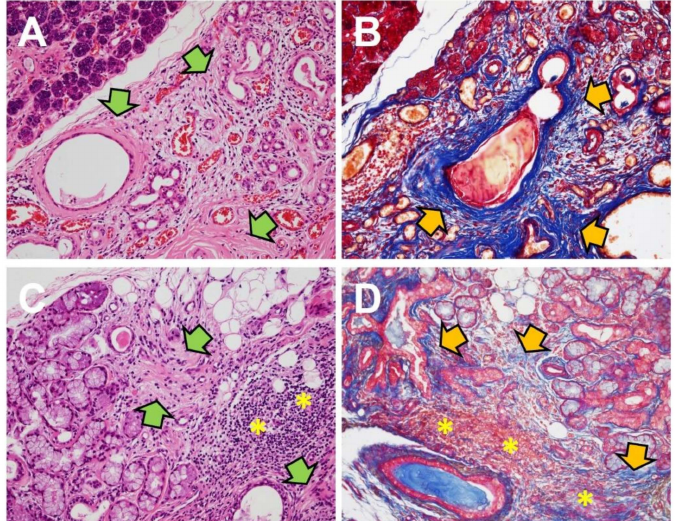
Figure 3. Fibrosis in salivary gland diseases. Under hematoxylin and eosin stain (left) and Masson’s trichrome stain (right), fibrosis is presented as dense pink collagen bundles (green arrows) and dense blue collagen bundles (yellow arrows), respectively. ( A , B ). Fibrosis in sialadenitis of the submandibular gland ( × 200). ( C , D ). Fibrosis adjacent to lymphocytic aggregation (asterisks) in labial minor salivary glands diagnosed as Sjögren syndrome ( ×